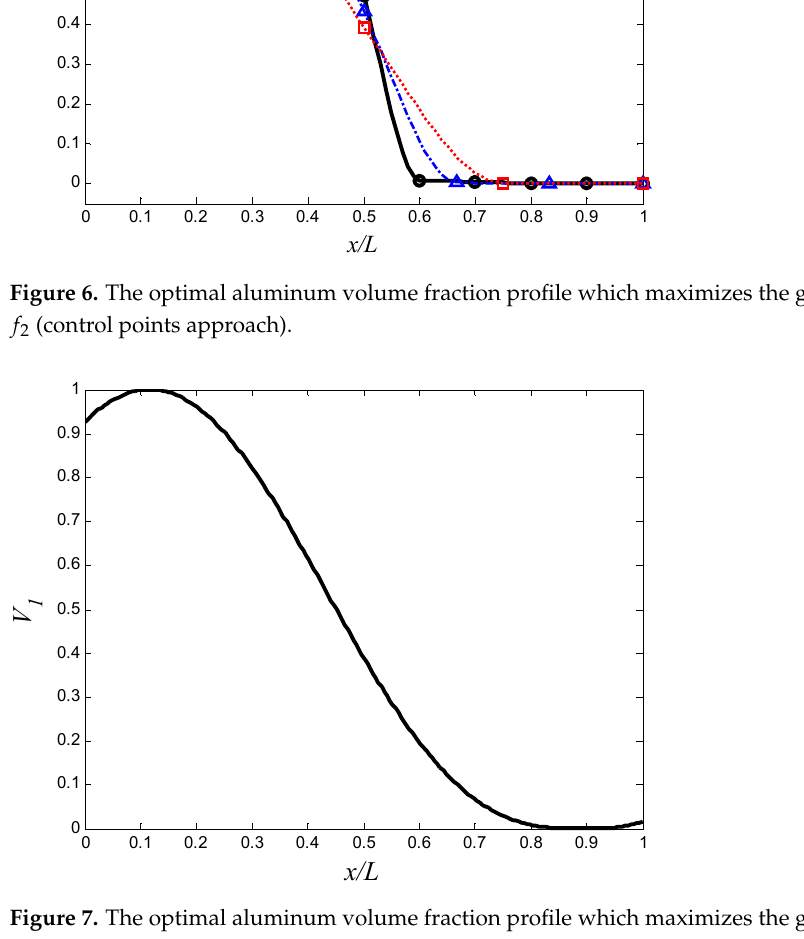
Figure 7. The optimal aluminum volume fraction profile which maximizes the gap between f 1 and f 2 (trigonometric law, Equation (2)).